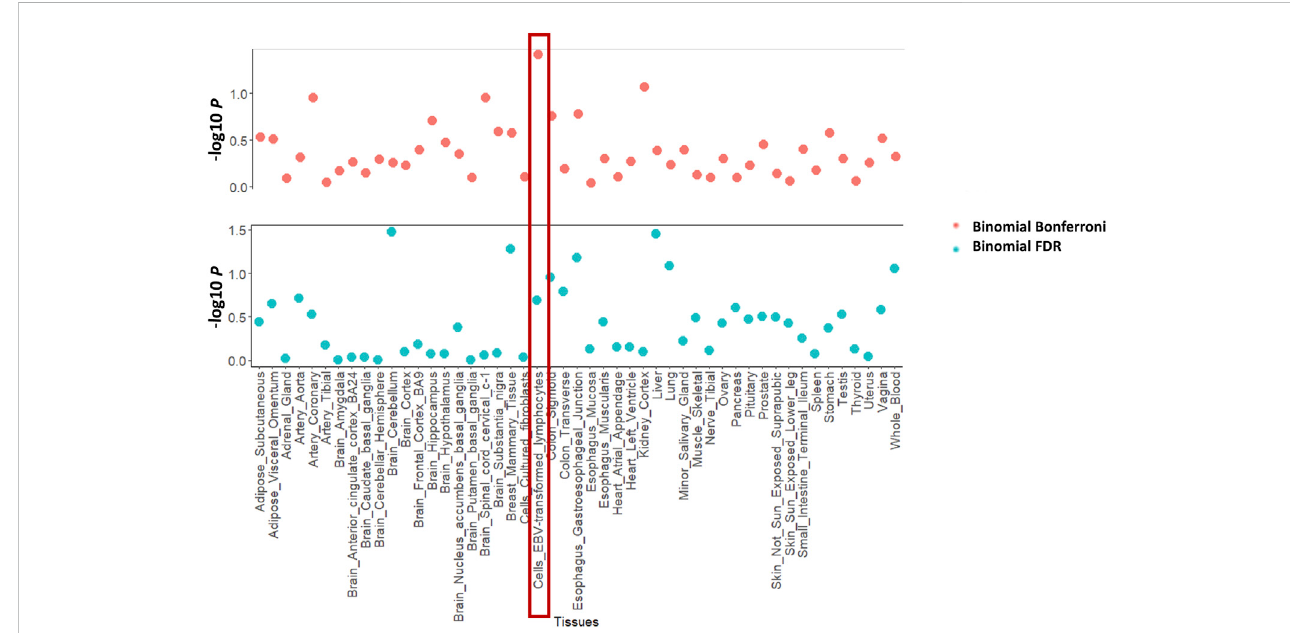
FIGURE 3 Enrichment methods used in this study for one of the training GWAS datasets (asthma). It shows the enrichment with the binomial test with Bonferroni and FDR